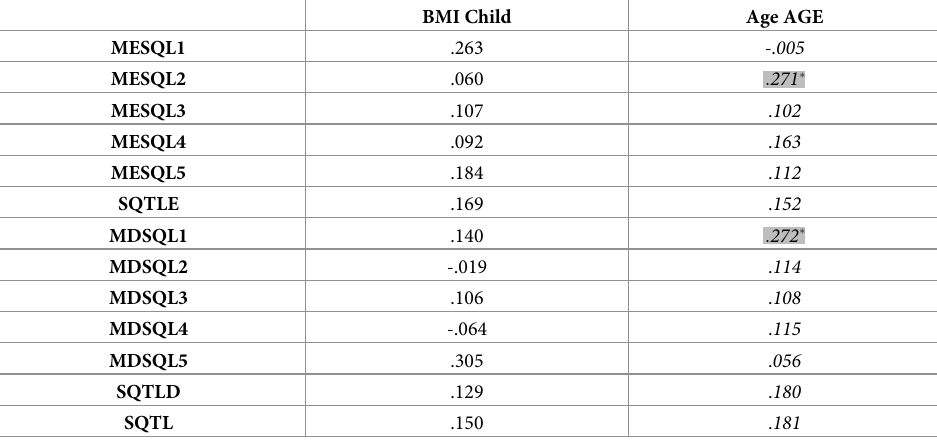
considering that men and women have different dermatoglyphic patterns [30, 31], when the sample was analyzed according to the gender only the male individuals showed a significant difference in the MDSQL1 finger (right thumb), i.e., the greater the number of ridges, the greater the BMI. There was a relationship between BMI and MDT1 fingerprint pattern in male individuals, with a higher frequency of the ulnar loop (UL) pattern in the obese group. The analysis of the association between BMI, fingerprints and gestational data showed no signifi- cant differences; however, the analysis of the correlation between the number of finger ridges, Table 4. Correlation between number of ridges on the fingers, BMI child, and age of onset of pregnancy of the mother (AGM age) female.